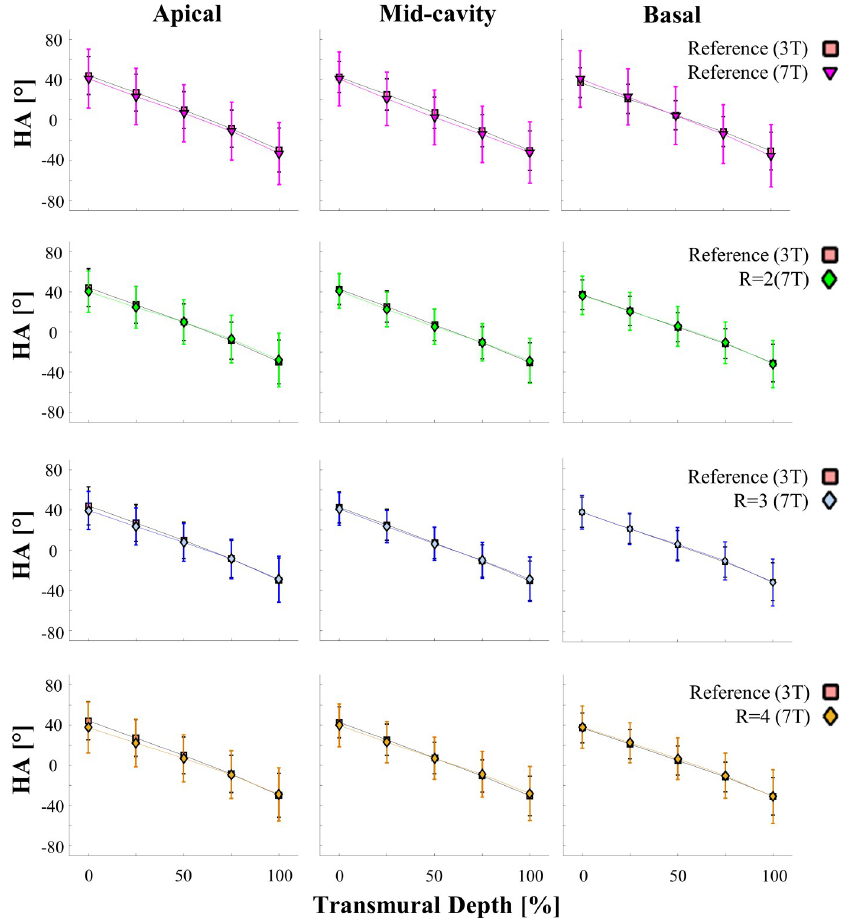
Fig 5. Average transmural helix angle profiles at 7 T and 3 T for apical, mid-cavity, and basal segments. Data was derived from the reference scan at 3 T, the reference scan at 7 T and scans with increasing GRAPPA factors R = 2, R = 3, and R = 4 at 7 T. Data points are displayed for five myocardial layers endocardial, sub-endocardial, mid-wall, sub-epicardial, and epicardial as mean ± one standard deviation. Profiles show helix angle values as a function of transmural depth